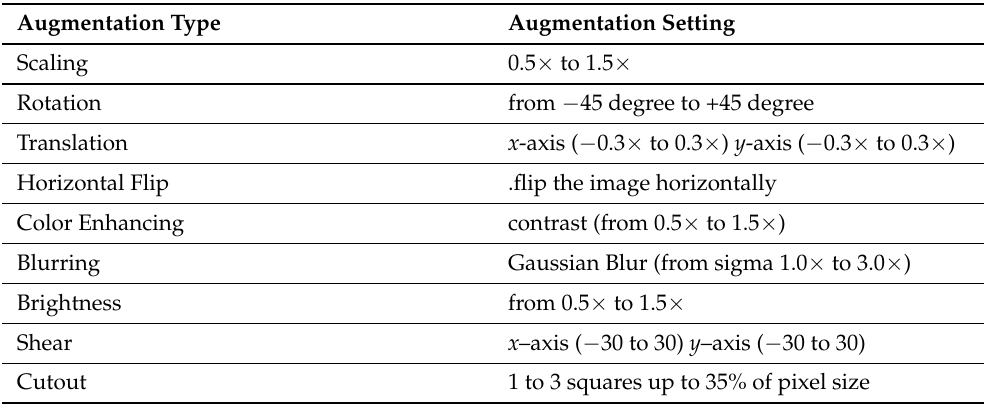
Table 2. Augmentation types and